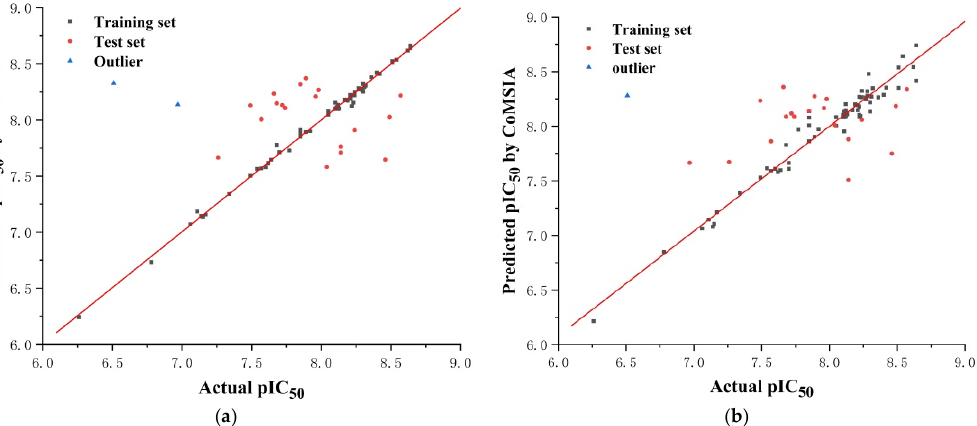
Figure 10. The correlation plots of the predicted pIC 50 values versus the actual pIC 50 values using the training set and the test set based on the CoMFA (a) model and the CoMSIA (b) model, respectively.